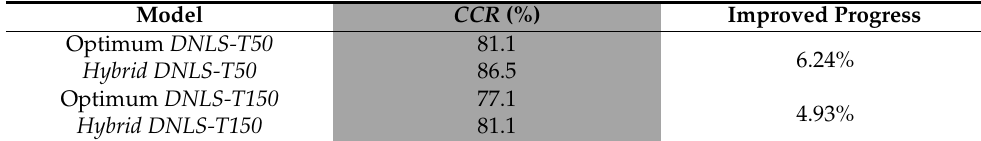
Table 4. Comparing the CCR and model improvement using validation data.